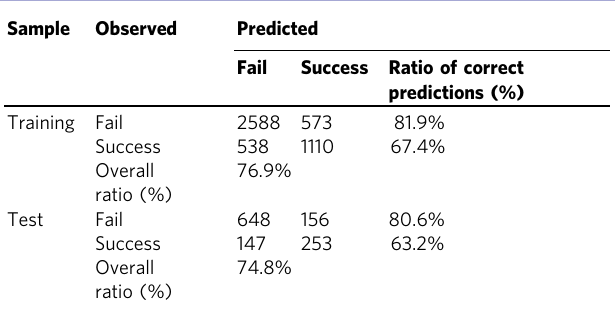
Table 5 Results of classi fi cation using the CHAID method by samples of